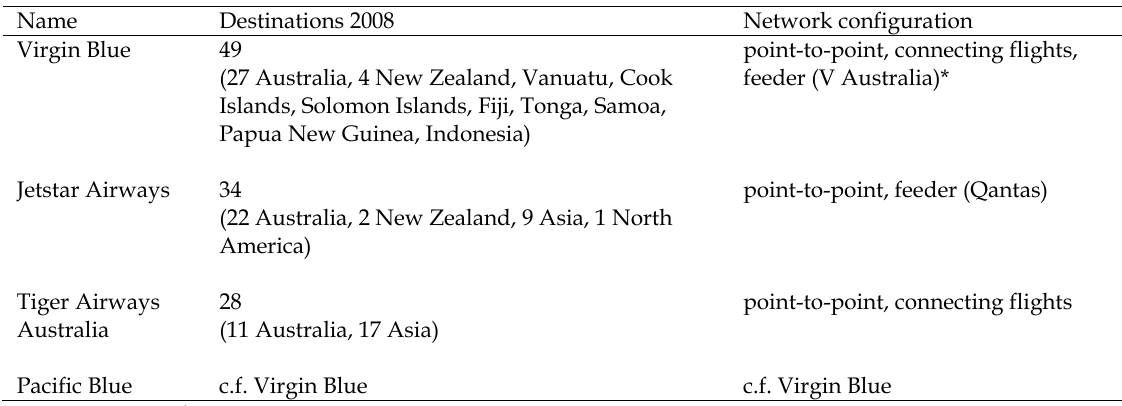
Table 5: Destinations, Routes and Network Configurations (February